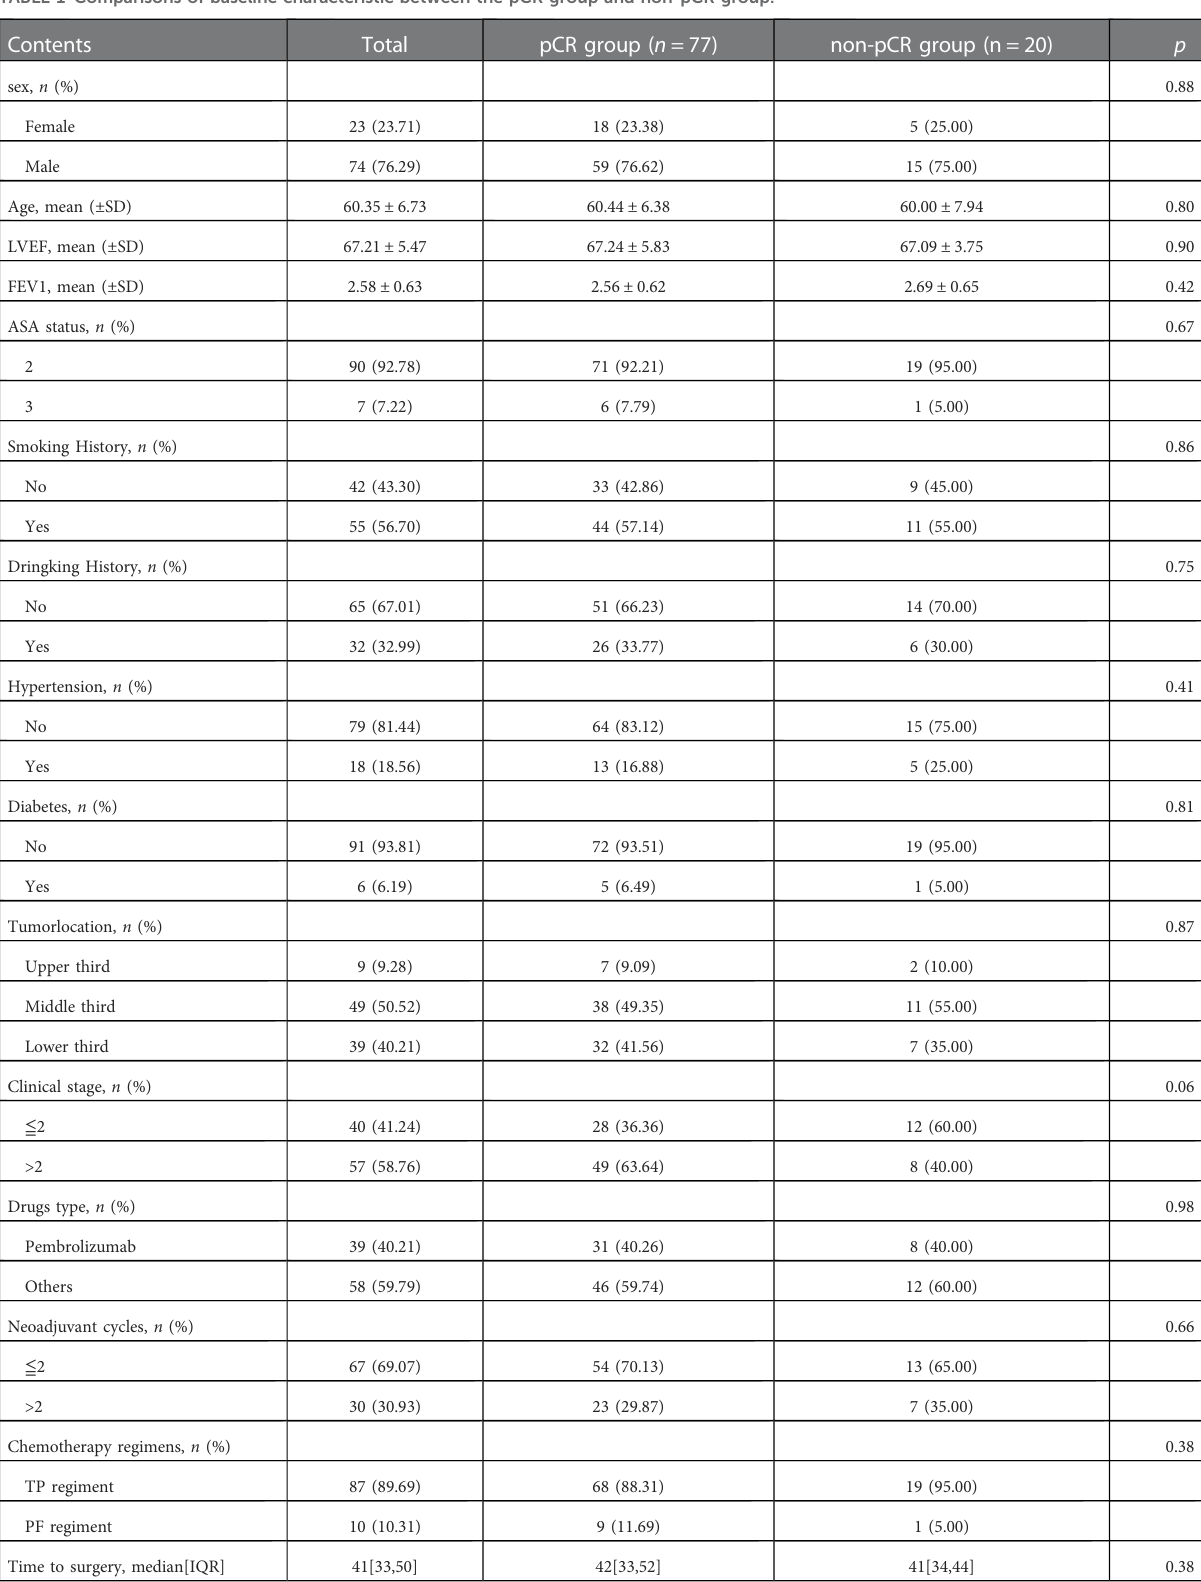
TABLE 1 Comparisons of baseline characteristic between the pCR group and non-pCR